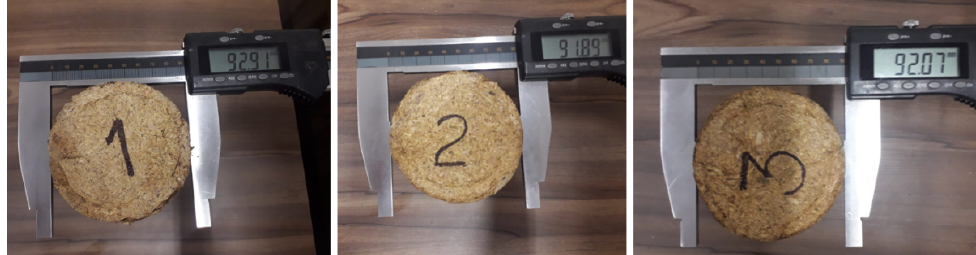
Figure 7. Produced briquettes have a variation in diameter, although perfectly normal.